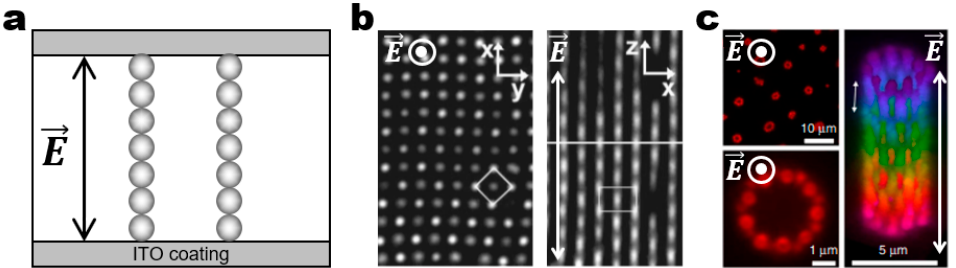
Figure 6. Field-driven dynamic structuring in a high-frequency vertical electric field. ( a ) Schematic of the experimental setup for a vertical AC electric field along the z -direction. Upon application of the high-frequency field, the dispersed particles experience strong dipolar attractions and electric torques, leading to the formation of linear chains aligned parallel to the field direction. ( b ) Assembly of 0.525 µm silica spheres into body-centered tetragonal (BCT) crystal structures. (left) The xy -plane view illustrating the BCT lattice. (right) The xz -plane view illustrating the assembled linear chains aligned parallel to the field direction. Reproduced with permission [52]. Copyright 2000, American Institute of Physics. ( c ) Assembly of ellipsoidal particles into tubular structures. (left) The xy -plane views illustrating the empty circle inside the assembled tubular structures. (right) The representative tubular structure aligned along the z -axis. Reproduced with permission [54]. Copyright 2014, Nature Publishing Group. The circle and dot with the electric fi eld denote that the fi eld is applied perpendicular to the plane of view in (b) and (c).